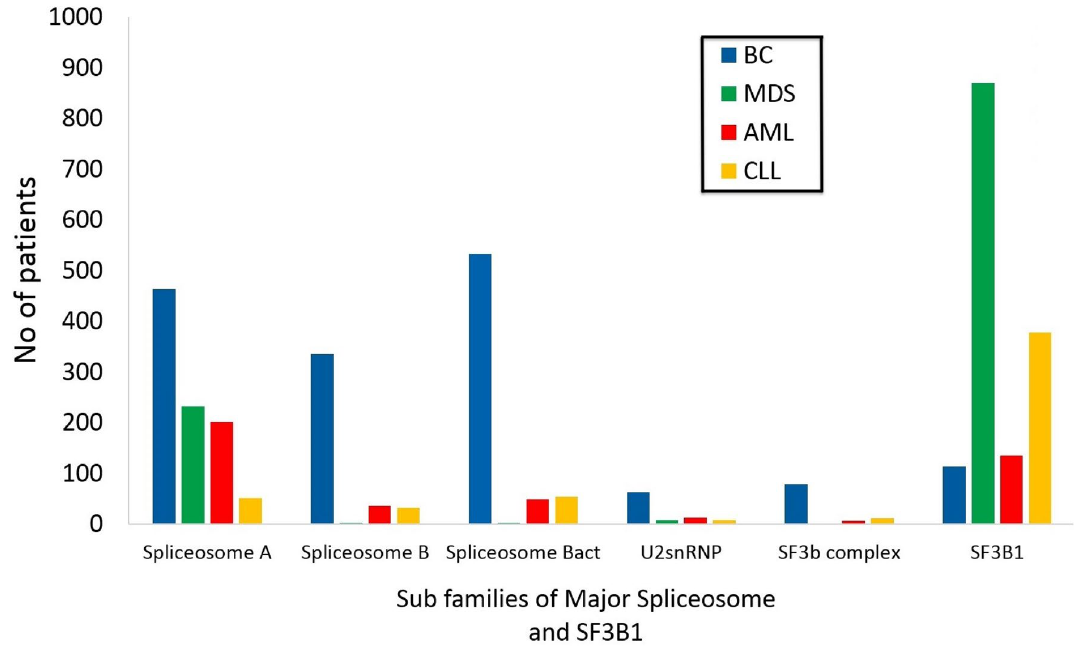
Figure 7. A clustered bar chart shows the contribution of each subgroup of major spliceosome gene group to BC, MDS, AML, and CLL, these are colored in blue, green, red, and yellow,